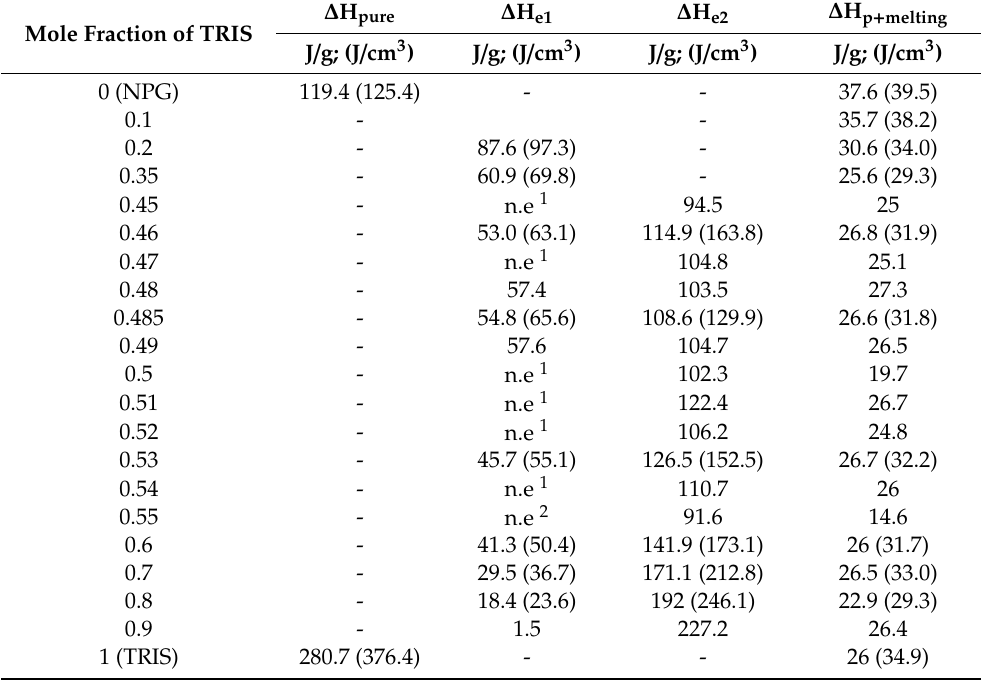
Table 4. Enthalpies of phase transition in NPG-TRIS system: ∆ H pure , pure NGP and TRIS, ∆ H e1 , low temperature eutectoid reaction; ∆ H e2 , high temperature eutectoid transformation; ∆ H p + melting , peritectic reaction (when applies) and